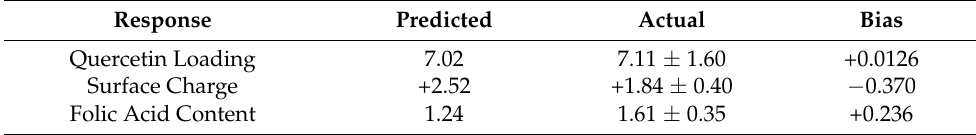
Figure 3. Prediction profiler showing optimized solution with maximum desirability, from JMP V17. Table 3. Responses obtained using varying amounts of quercetin, chitosan, and folic